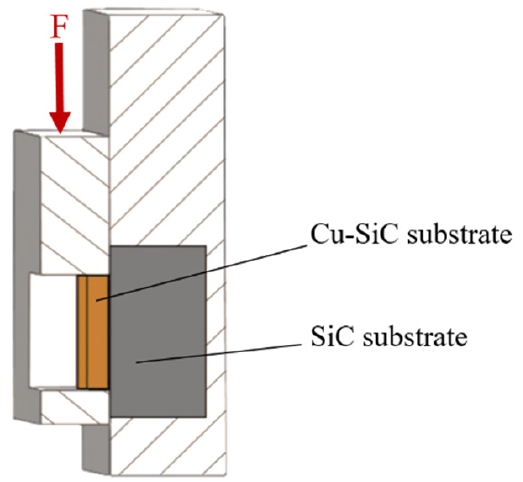
Figure 6. Scheme of shear strength measurement.